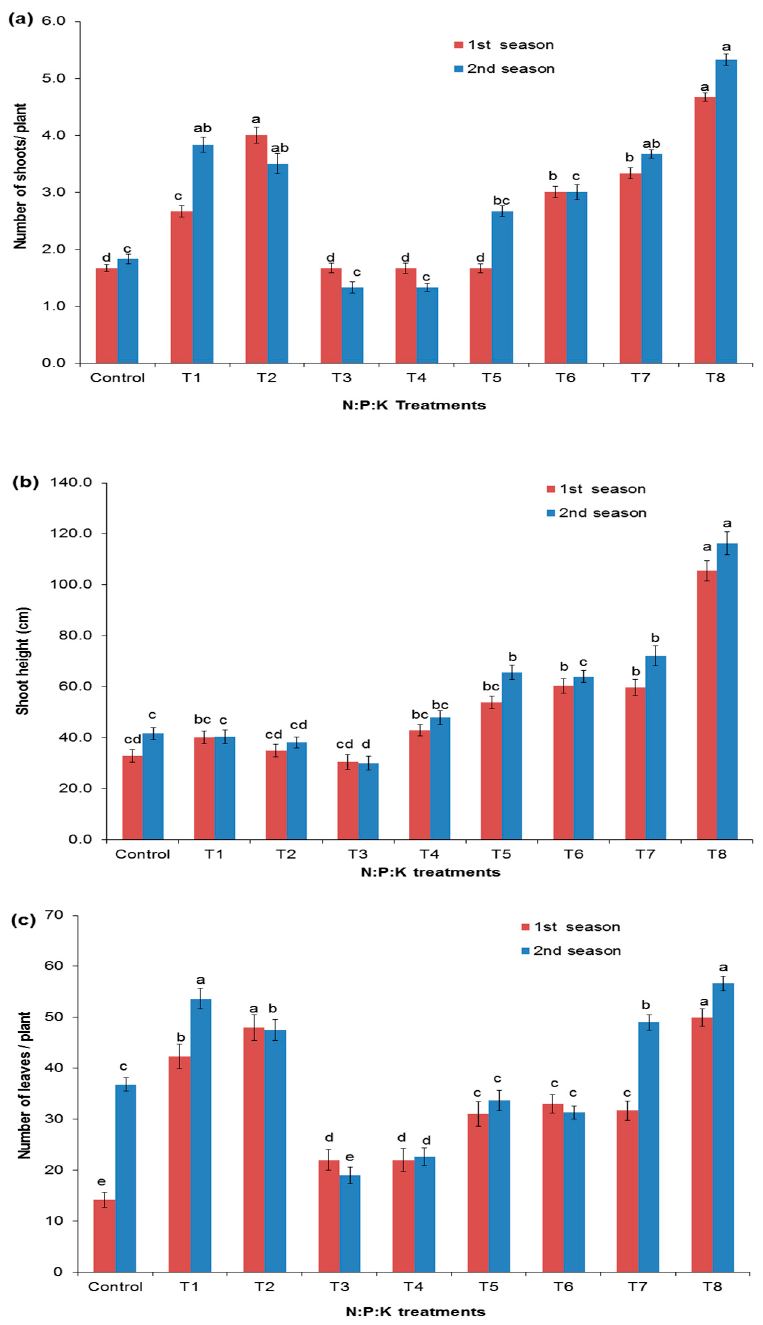
Figure 1. Effect of NPK treatments on the number of shoots ( a ), the shoot heights ( b ), and the number of leaves ( c ) of Salvadora persica . Dissimilar letters designate the significance among means ( p < 0.05) using Duncan’s multiple range test (means ± standard errors ( n = 5)) for the different fertilization treatments.